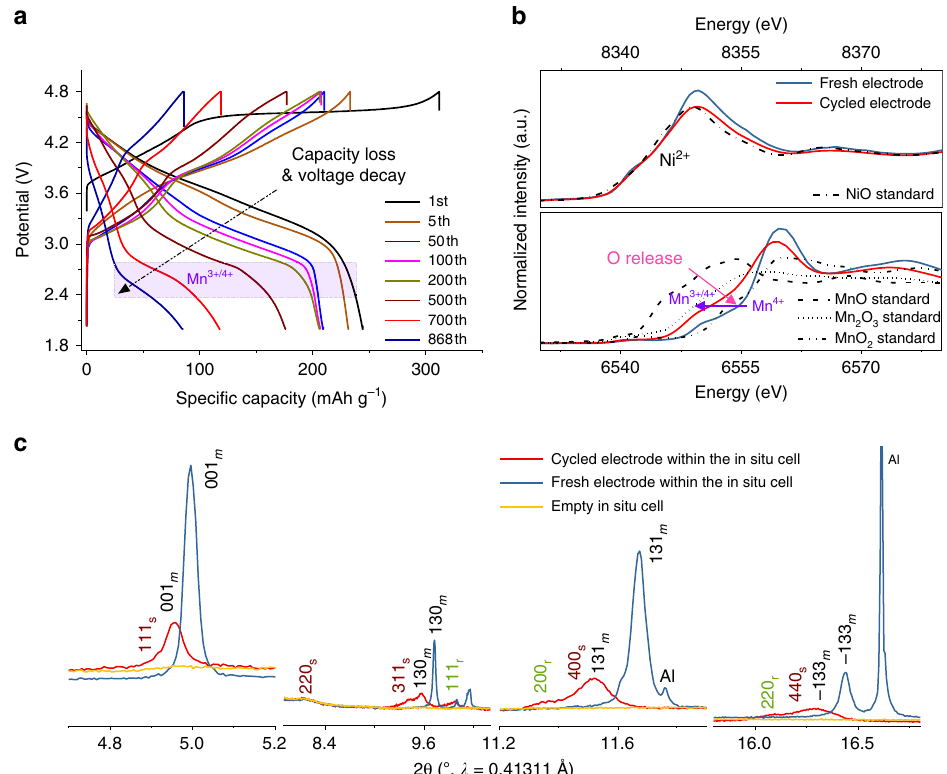
Fig. 3 Structural degradation of Li[Li 0.2 Ni 0.2 Mn 0.6 ]O 2 (L1.28) cathode after long-term cycling. a Selected charge and discharge curves of a L1.28/Li cell during prolonged cycling; b Ni K-edge and Mn K-edge XAS spectra of the fresh and the cycled L1.28 electrode (after 868 cycles) measured within an in situ coin cell, respectively; c their corresponding SRD patterns, and the SRD pattern of the empty in situ coin cell as a